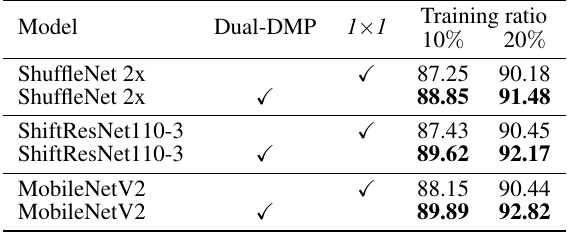
Table 1. Ablation study on NWPU-RESISC45 data set.